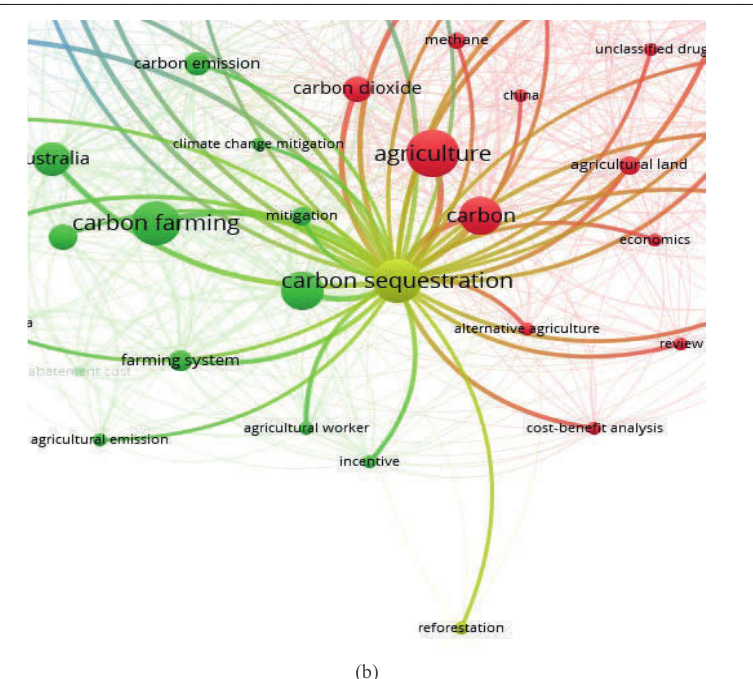
Fig. 2. Carbon farming links and